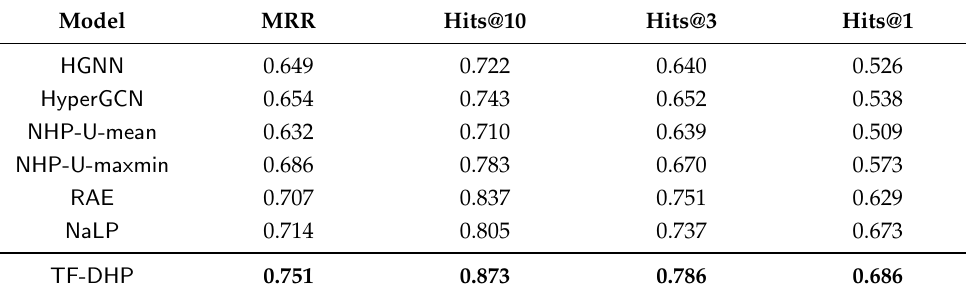
Table 5. Undirected hyperlink prediction results on JF15K